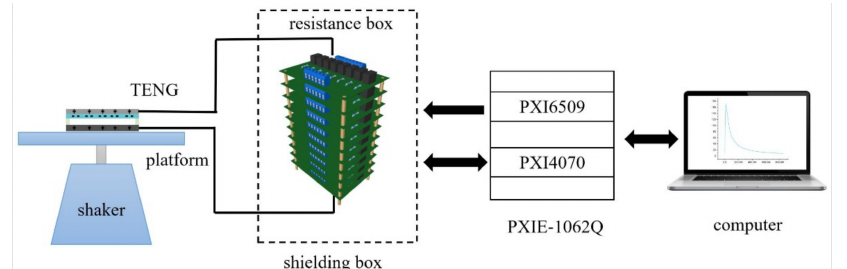
Figure 6. Schematic diagram of the APEW